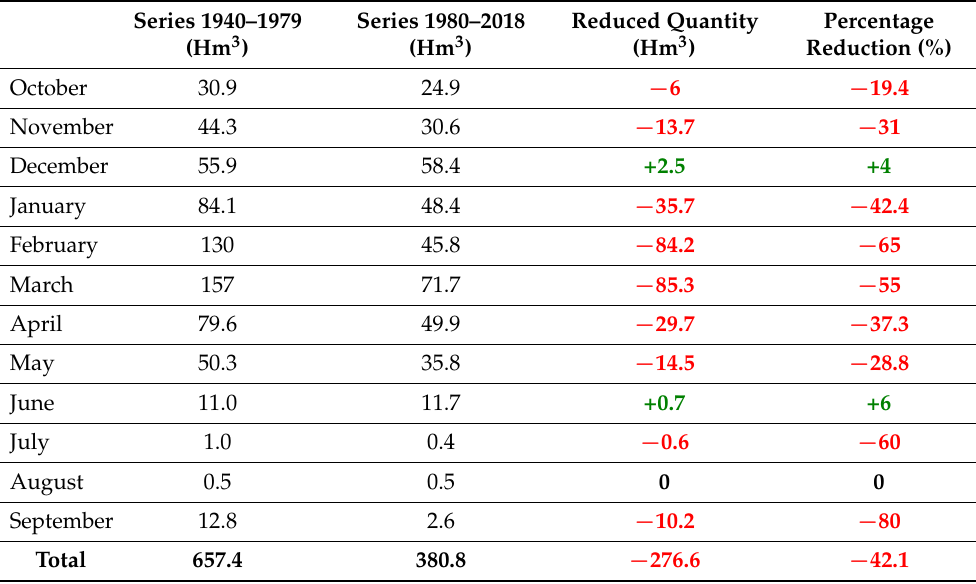
Table 3. Calculations of average monthly/annual runoff decrease and percentages in the Upper Tagus (series 1940–1979 and